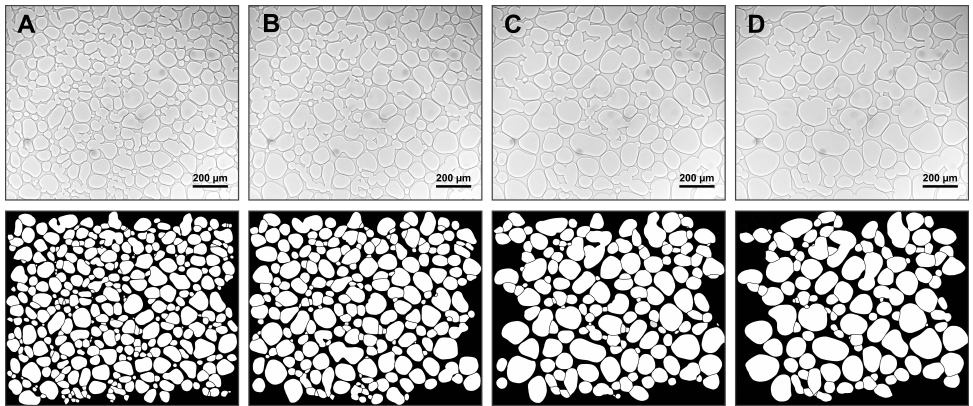
Figure 6. FDM pictures with 20 × magnification of a 10% ( w / w ) sucrose solution during annealing for different times (( A ) = 60 min, ( B ) = 120 min, ( C ) = 240 min, ( D ) = 360 min) at − 6 °C ( upper row ). Corresponding labelled pictures show crystalline phase in white and amorphous matrix in black ( lower row ).